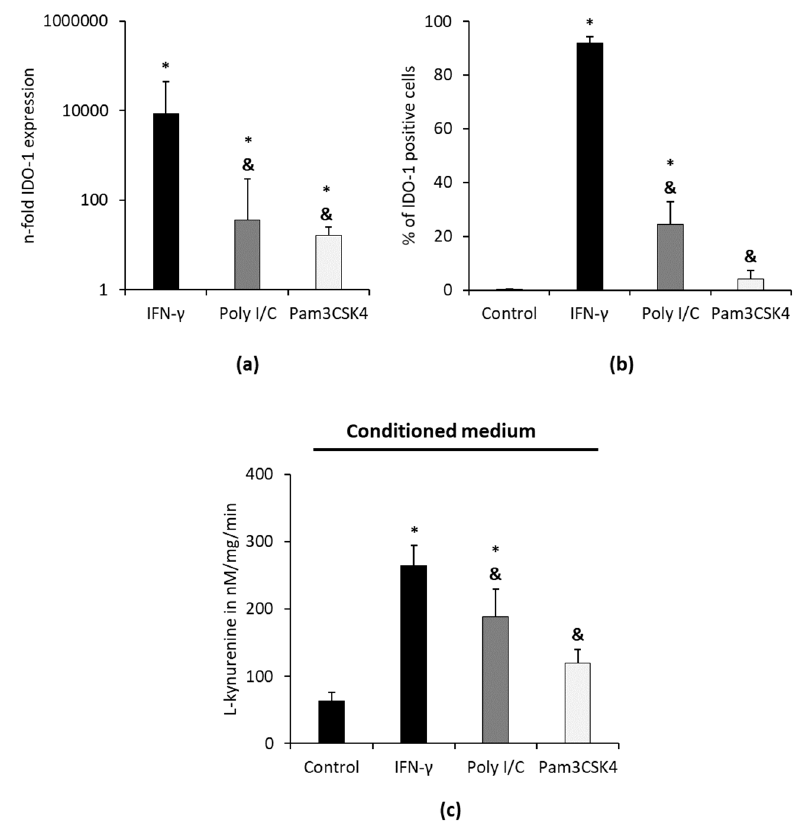
Figure 4. Effect of toll-like receptor (TLR) agonists Poly I/C and Pam3CSK4 on the IDO-1 gene and protein expression and on the enzymatic activity in hPDLSCs. Primary hPDLSCs were stimulated